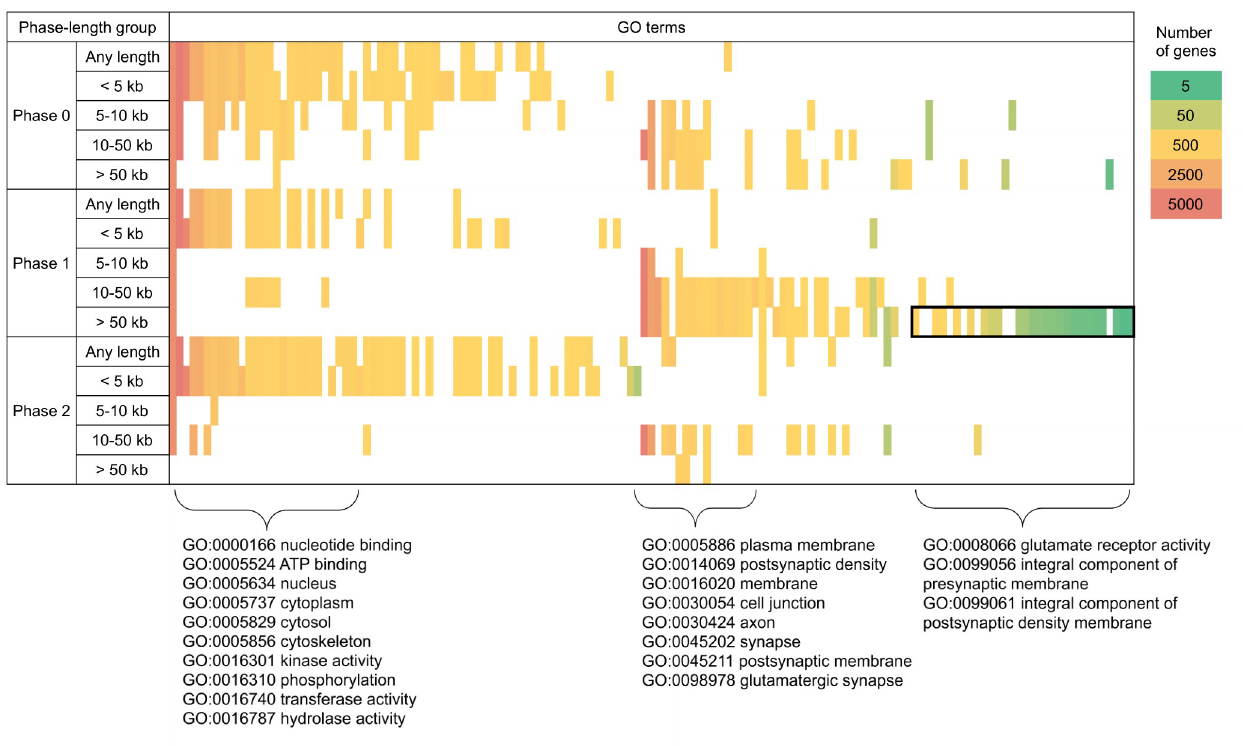
Fig 1. Genes containing introns of particular length and phase are enriched with multiple GO-terms. Rows—’phase-length’ intron groups, columns—GO- terms. The cells with significant enrichment (1% FDR) are colored. Color scale reflects the total number of genes associated with a particular GO term. Columns have been arranged manually by placing the GO-terms enriched with the shorter groups of introns on the left, GO-terms enriched with the groups of long introns on the right, and then sorting within those two halves of GO-terms by their sizes keeping similar rows close to each other. The GO-terms enriched with phase 1 introns longer than 50 kilobases only are emphasized with the black frame. Curly brackets mark out the clusters of similar GO-terms and are followed with the particular terms that demonstrate the most significant